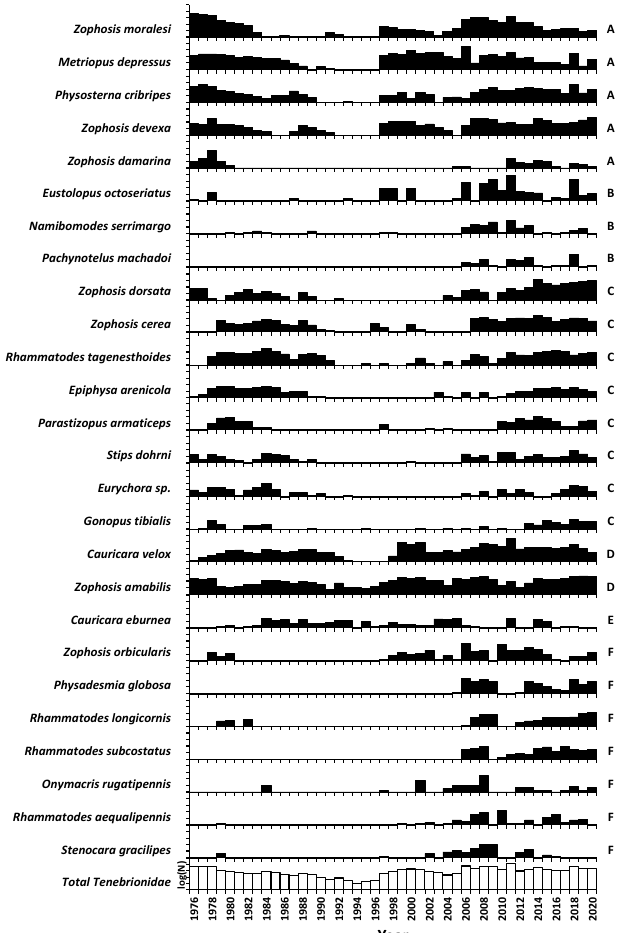
Figure 5. Autocorrelations of the annual abundances of ( a ) Zophosis devexa and ( b ) Caurica velox . Dotted lines are confidence limits. All but one of the 26 focal species was recorded in at least 22 years, one in every year (Table 1). The abundance tracks of the 26 focal species could be allocated to six clusters ( p < 0.001, Ward’s method—Pearsons-r, Figure 6). Group partners matched each other, with one species, Cauricara eburnea being unique, not matching any other species ( p > 0.05, Fig- ure 6).